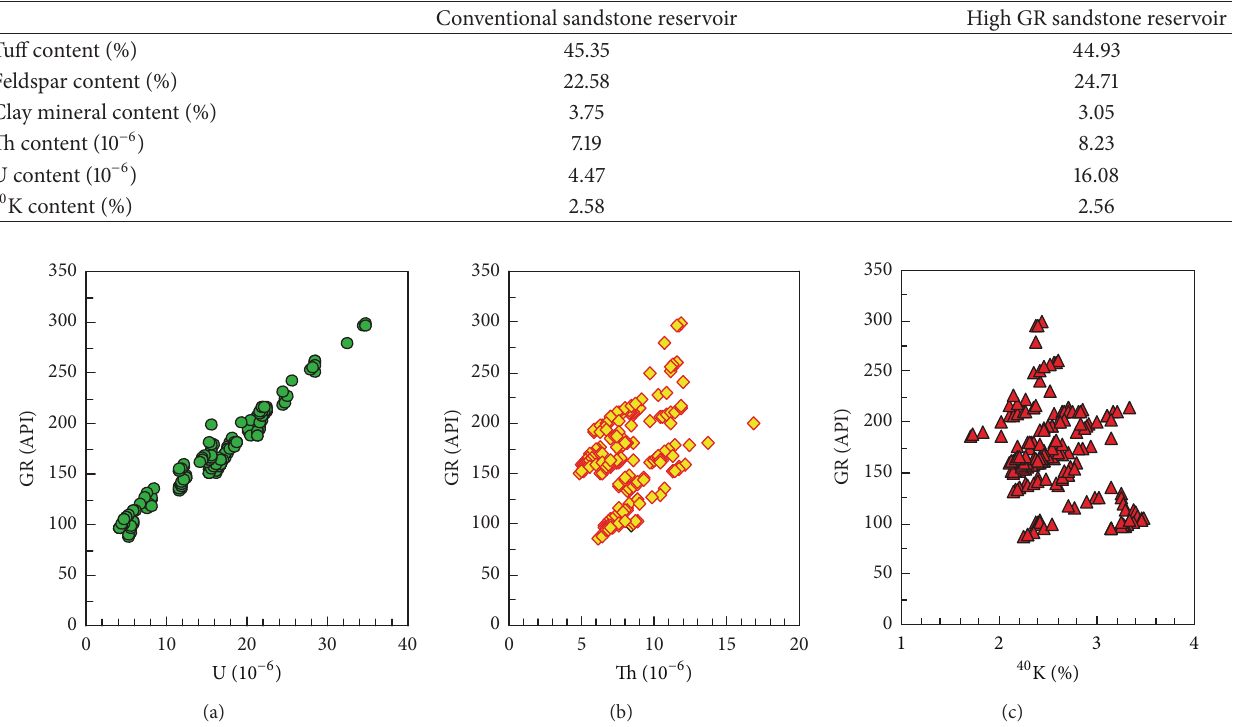
Table 1: The tuff content, feldspar content, clay mineral content, U, Th, and 40 K in conventional sandstone reservoir, and high GR sandstone reservoir.